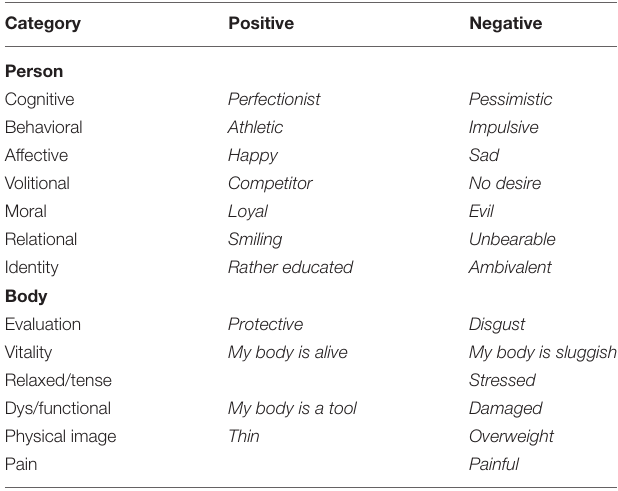
TABLE 2 | Examples of positive and negative words for each category given by participants to describe their person and their